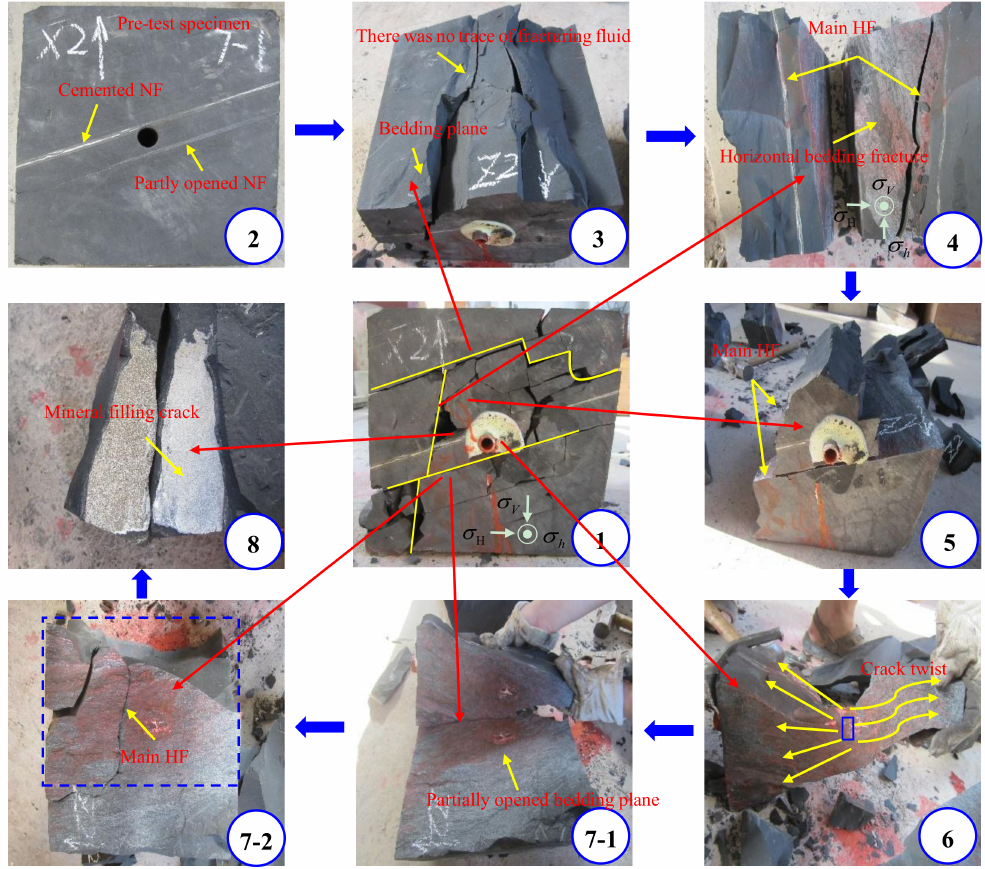
Figure 19. Photographs of specimen Y-7-1 after conducting